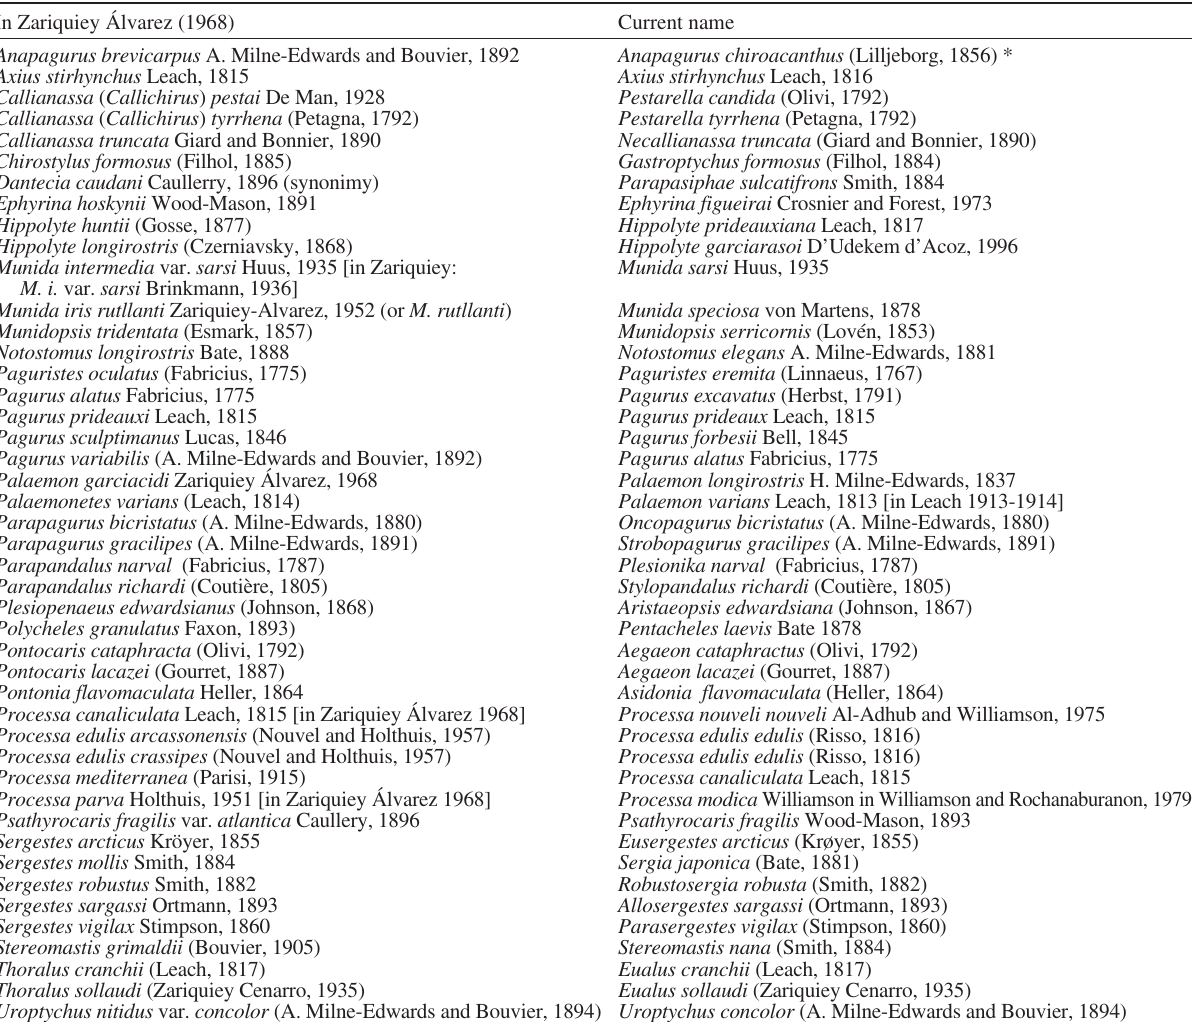
Table 1. – Changes in the generic or authority assignation of species in comparison with Zariquiey Álvarez (1968) as well as synonymized species, listed by taxonomic hierarchy. * According to Garcia Gómez (1994) and WoRMS. In Zariquiey Álvarez